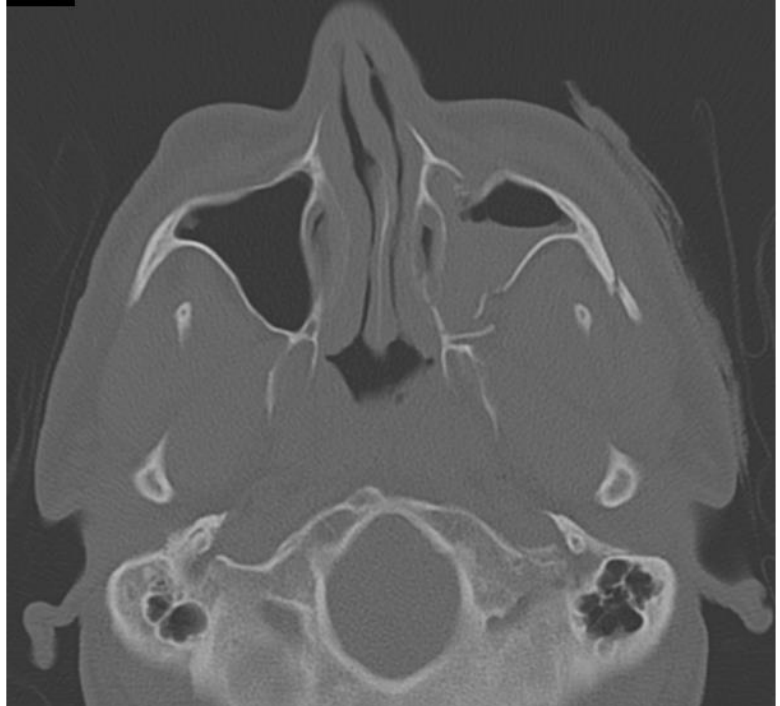
Figure 8. Trauma CT in axial view with visible orbital, zygomatico-malar fractures and displaced zygomatic arch.